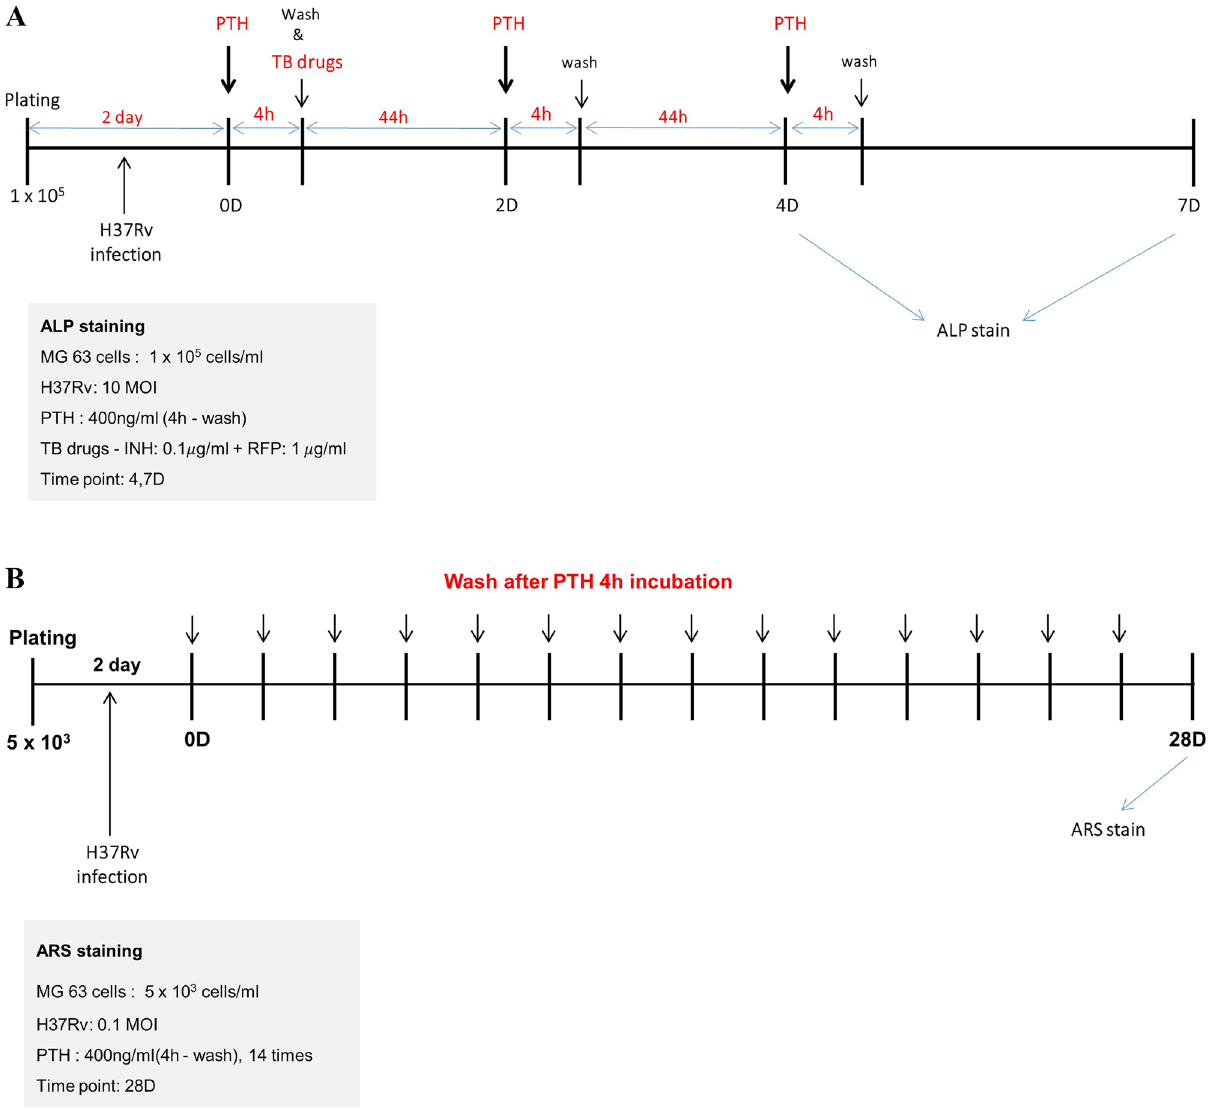
Figure 8. Experimental protocol for measuring osteoblastic activity of Mycobacterium tuberculosis (Mtb)- infected MG-63 cells. ( A ) ALP and ( B ) ARS staining. Abbreviations: ALP, alkaline phosphatase; ARS, Alizarin red S; INH, isoniazid; MOI, multiplicity of infection; PTH, teriparatide; RFP, rifampin; TB,